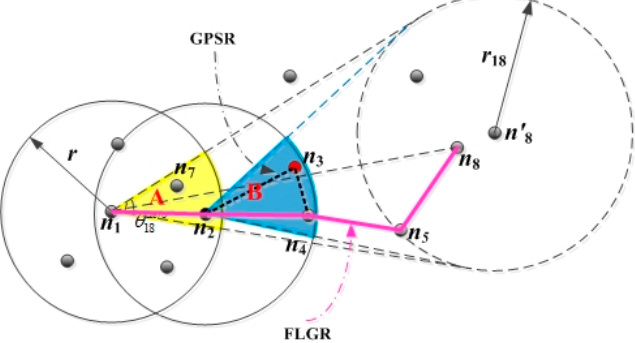
Figure 1. Fuzzy logic-based geographic routing protocol (FLGR) forwarding mode.